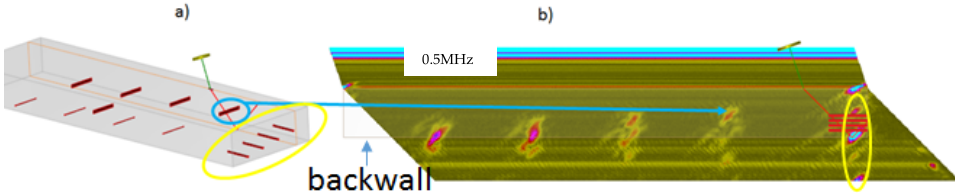
Figure 16. ( a ) Configuration of ultrasonic pulse echo NDT of the embedded planar electro-eroded slots (depicted in Figure 13); ( b ) experimental True BScan using the immersion probe at 0.5 MHz. The entry surface and backwall of the component are indicated in grey. The slot utilized for validation is shown thanks to the blue arrow, whereas the yellow ellipse indicates the component right corners and the flat bottom holes.